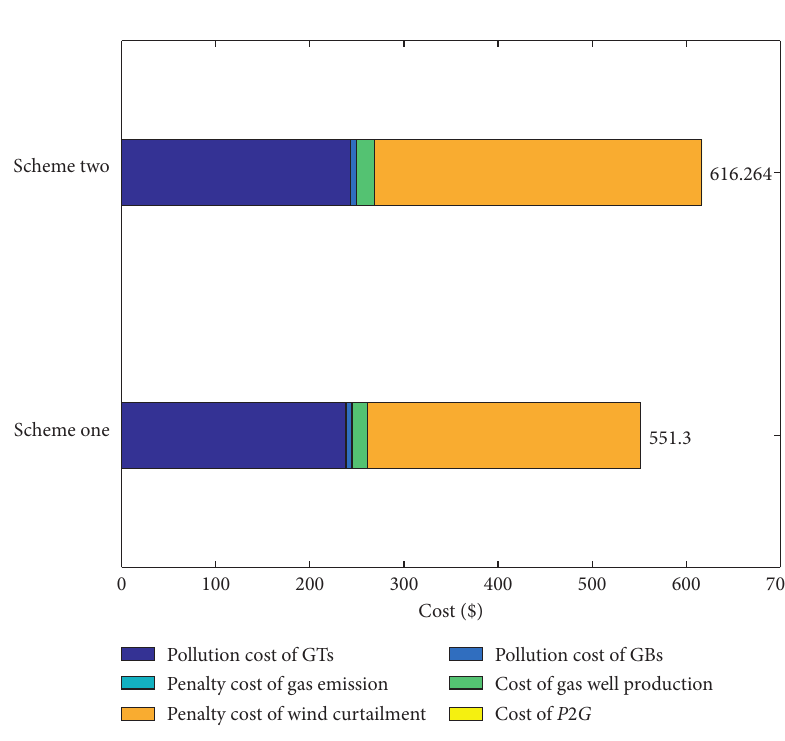
Figure 5: Operating cost structure under different